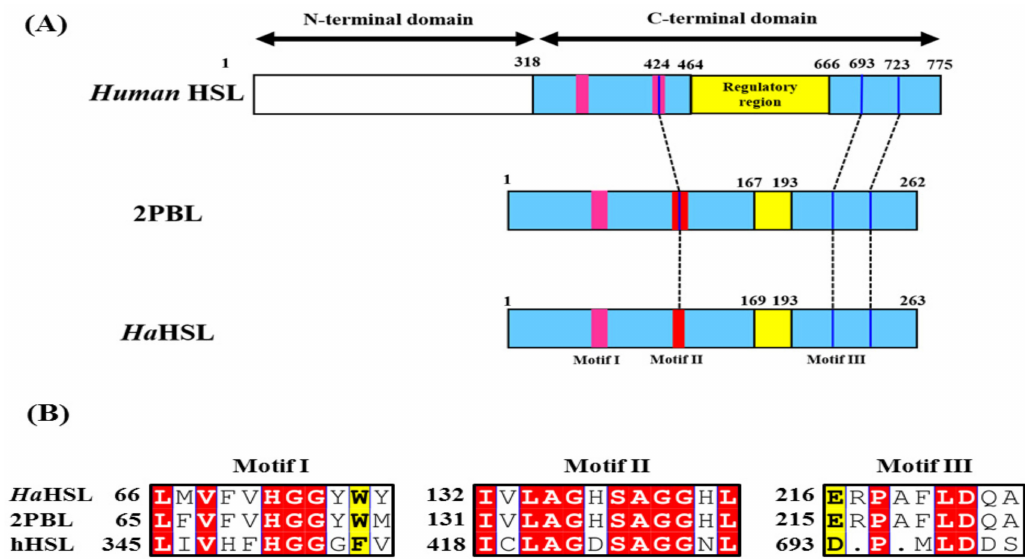
Figure 1. Structural organization of Ha HSL. ( A ) Schematic representations of human HSL (hHSL), 2PBL, and Ha HSL are shown. Three highly conserved sequence motifs are shown as red boxes and three catalytic amino acids are shown as black lines. Regulatory regions of these hormone-sensitive lipases are shown in yellow. ( B ) Sequence alignment of three conserved motifs (motif I, II, and III) in human HSL, 2PBL, and Ha HSL. Highly conserved residues are highlighted in